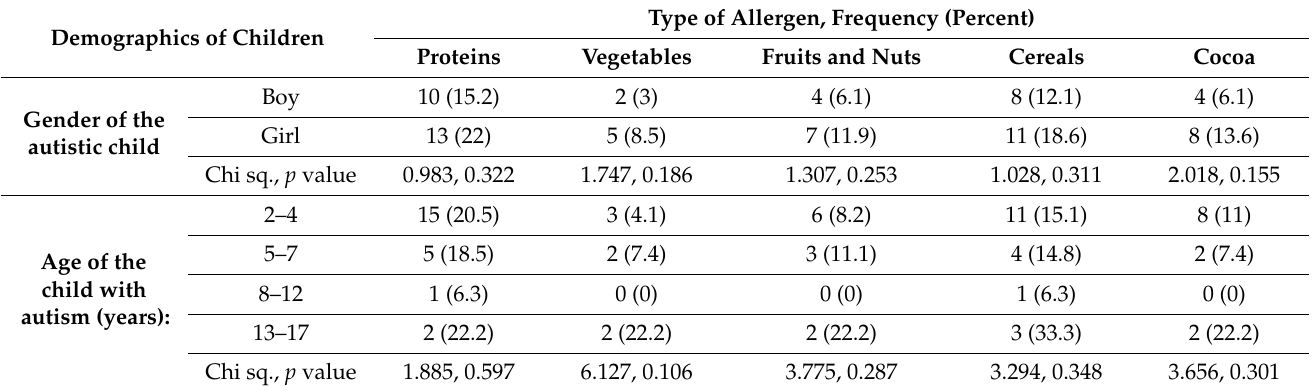
Table 3. Distribution of autistic children in terms of types of food allergens and their demographics. Type of Allergen, Frequency (Percent) Demographics of Children Proteins Vegetables Fruits and Nuts Cereals Cocoa